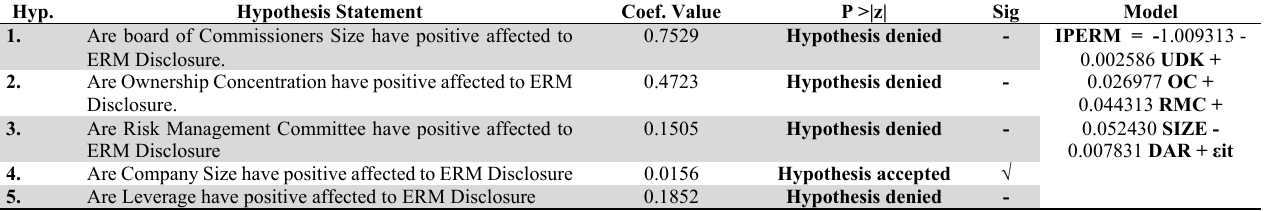
Research’s Hypotheses Test